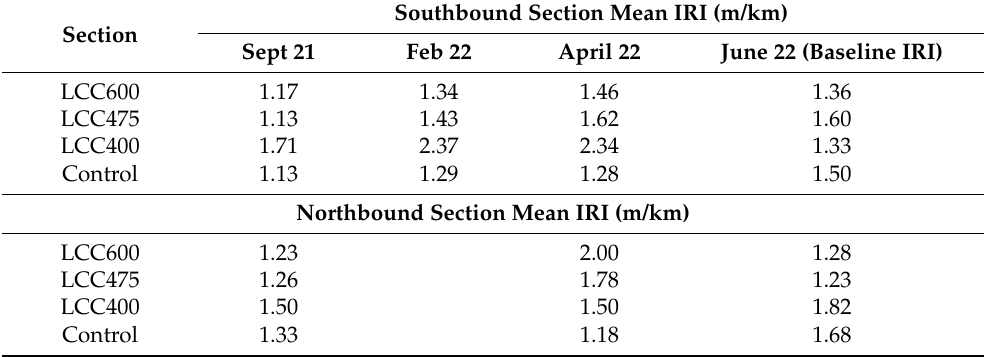
Table 3. Notre Dame Drive mean